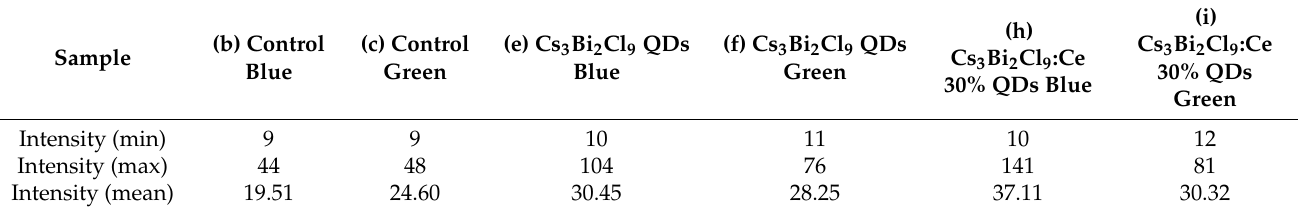
Table 6. Upconversion fluorescence intensity of selected cells.